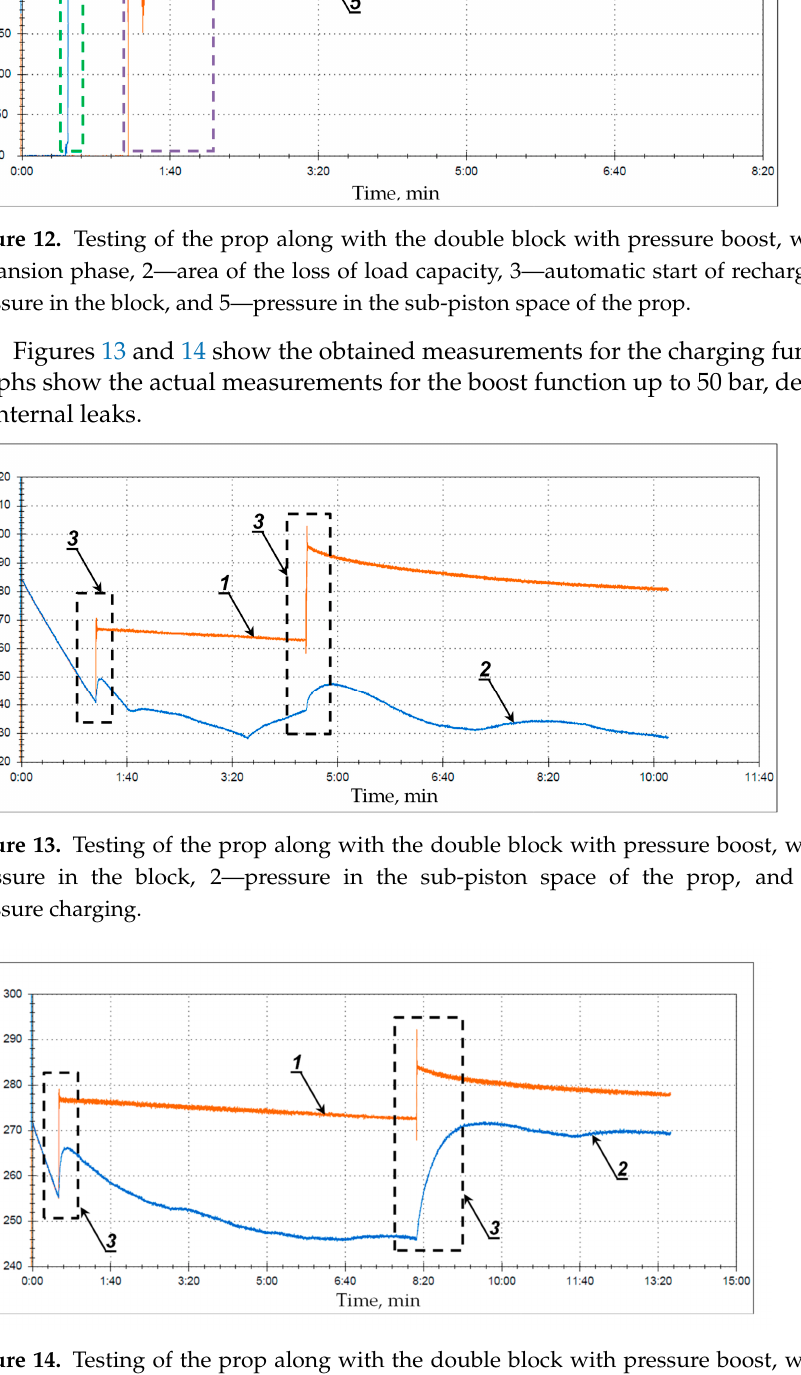
Figure 14. Testing of the prop along with the double block with pressure boost, where 1—boost pressure in the block, 2—pressure in the sub-piston space of the prop, and 3—automatic pressure